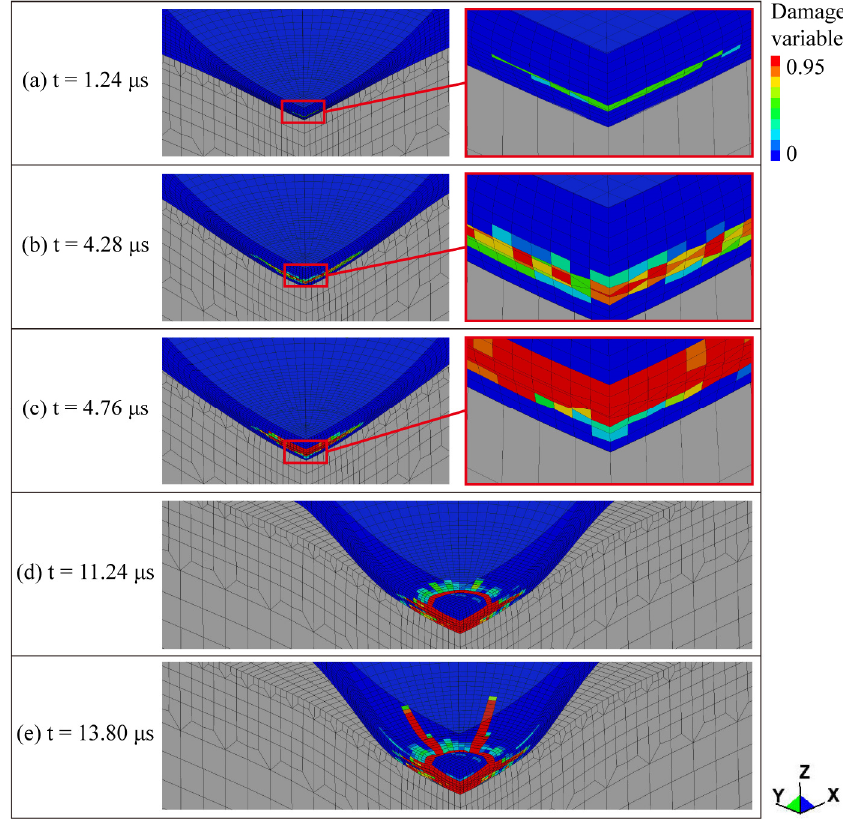
Figure 11. Polymer-ply damage evolution of automotive coatings. ( a ) 1.24 μ s, damage initiation occurs in the primer. ( b ) 4.28 μ s, the central damage of the basecoat appears. ( c ) 4.76 μ s, the central damage of the electrocoat occurs. ( d ) 11.24 μ s, a circumferential crack appears in the clearcoat. ( e ) 13.80 μ s, the radial cracks occur in the clearcoat and finally extend to the basecoat. The contour plot is displayed without interpolation of the damage variable.